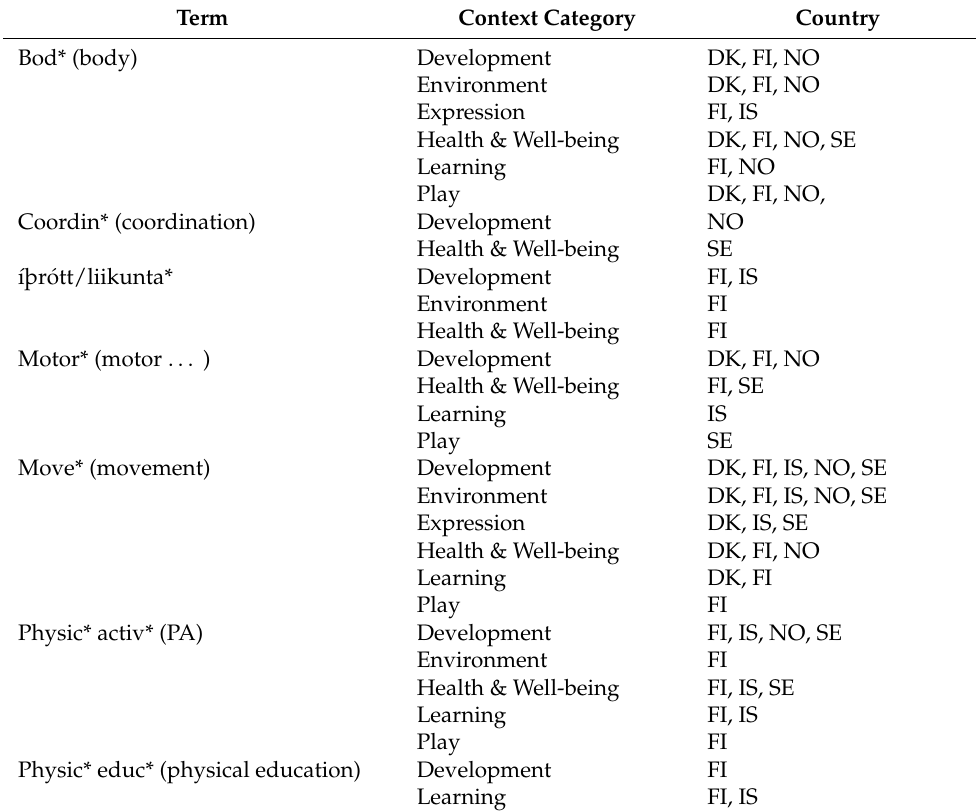
Table 2. Terms appearing in the national curricula from Denmark, Finland, Iceland, Norway and Sweden and their context